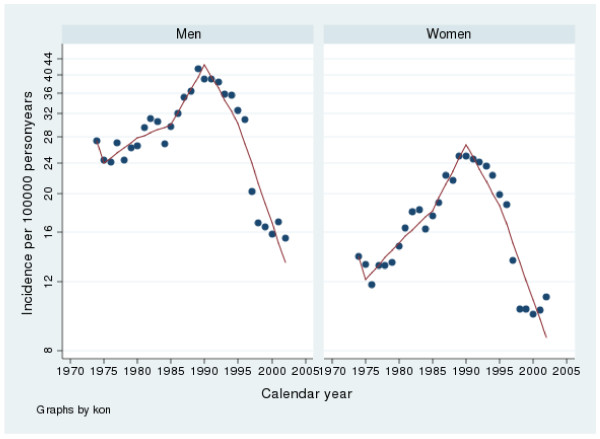
Incidence of gastric bleeding peptic ulcers in Sweden from 1974 to 2002. Note that the y-axis has been truncated.